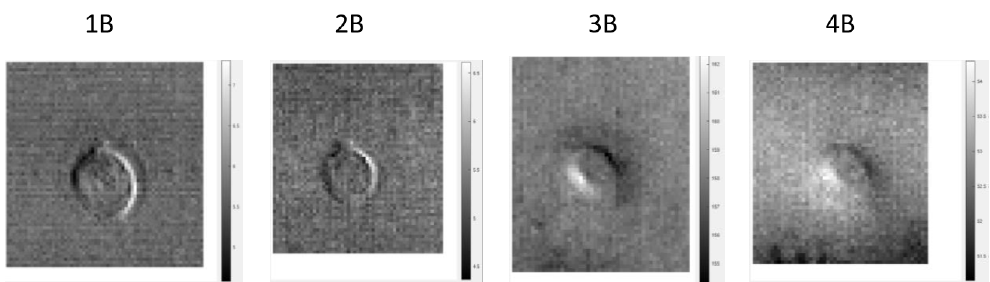
Figure 13. Results of the principle component analysis of the B-series samples heated from the